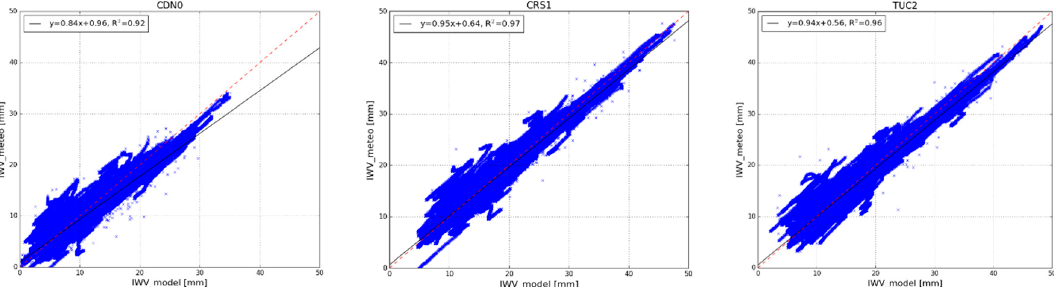
Figure 3. Scatterplots of the IWV (Precipitable Water) at the CDN0, CRS1 and TUC2 GNSS stations as determined using the VFM1 model (IWV_model) and in-situ measurements from meteorological sensors (IWV_meteo). It can be seen that the slope of the linear fit to the data is close to unity while its intercept is at the sub-mm level, with R 2 > 0.92 at the worst case.